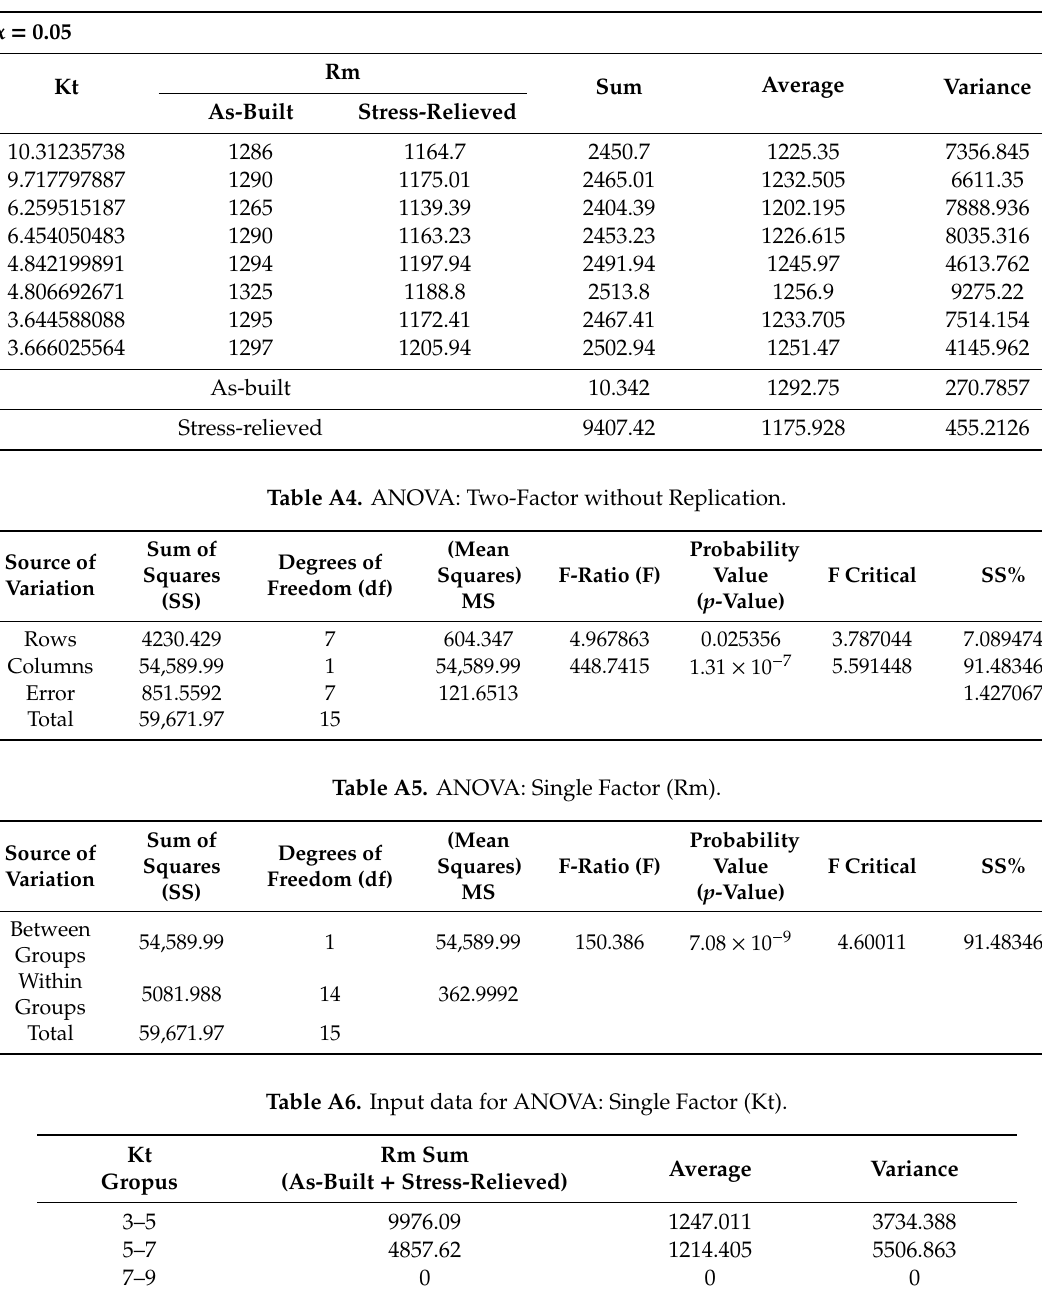
Table A3. Input data for ANOVA: Two-Factor without replication and ANOVA: Single Factor (Rm).